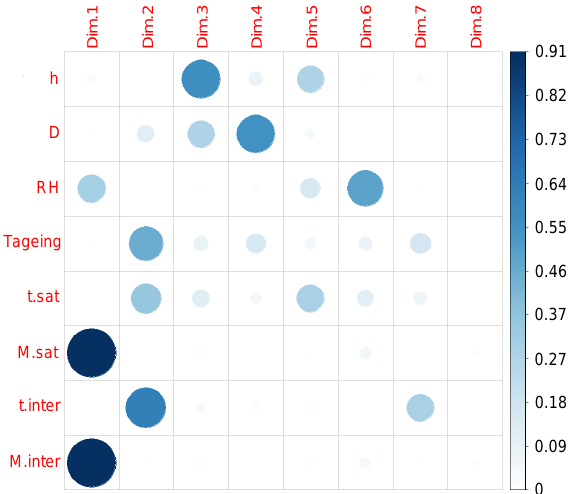
Figure 7. Representation quality of the study variables on the principal components of the overall PCA.